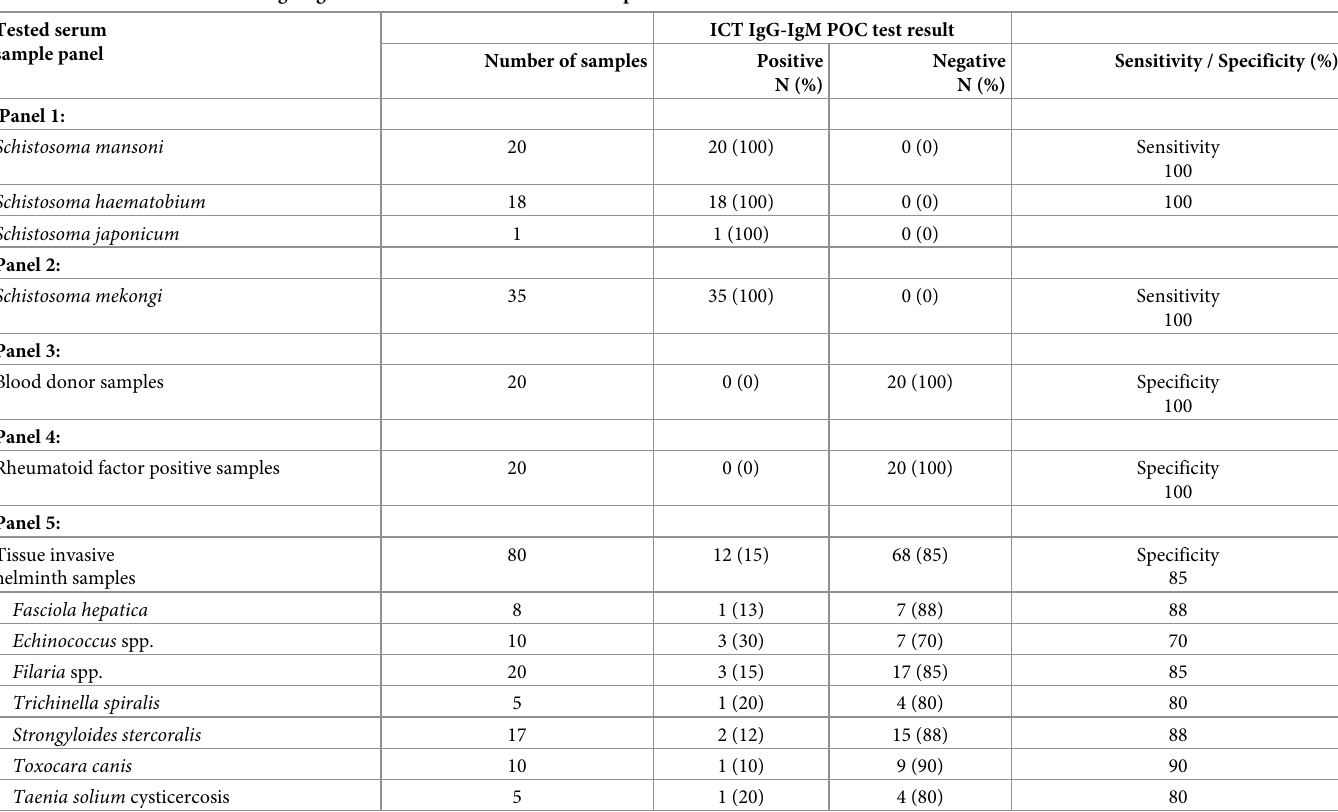
Table 1. Performance of the ICT IgG-IgM POC test in the five tested serum panels. Tested serum sample